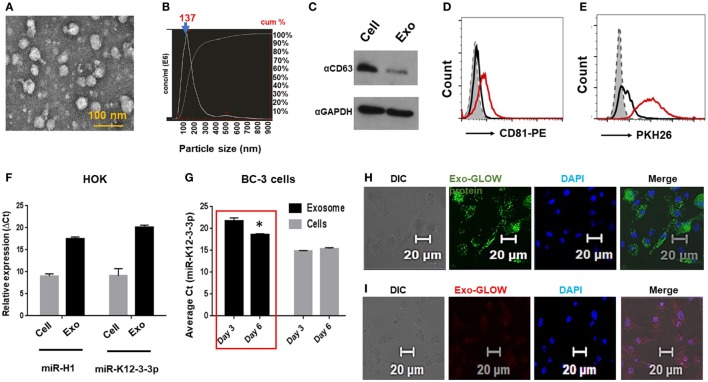
Oral keratinocytes derived exosomes carry v-miRs and deliver their contents into primary macrophages. (A) Electron microscopy image of exosomes isolated from human oral keratinocytes (HOK). Scale bar, 100 nm. (B) Size of the purified exosomes was analyzed on Nanosight Tracking Analysis. The particle size distribution and calculated original concentration of the HOK-derived exosomes. The arrow indicates the particle size (mode) of 137 nm. (C) Western blot showing detection of exosomal marker CD63 in the exosomal and cell lysates. Exosomes were bound to latex beads and then stained with exosome marker CD81 and labeled with lipid binding dye PKH26. Histograms showing (D) CD81 positive beads and (E) PKH26 staining indicating that isolated exosomes are membrane limiting vesicles. (F) Quantitative RT-PCR showing expression of v-miRs in cellular and exosomal RNA of miR-H1 transfected HOK. (G) High levels of miR-K12-3-3p secreted in the exosomes KSHV-infected BC-3 cells. miR-K12-3-3p expression in KSHV-infected cells and exosomes was analyzed by qPCR. Confocal images showing purified HOK exosomes deliver (H) protein and (I) RNA contents inside primary human Mφ. Scale bar, 20 µm. Student’s t-test was conducted to calculate p-values (*p < 0.05).